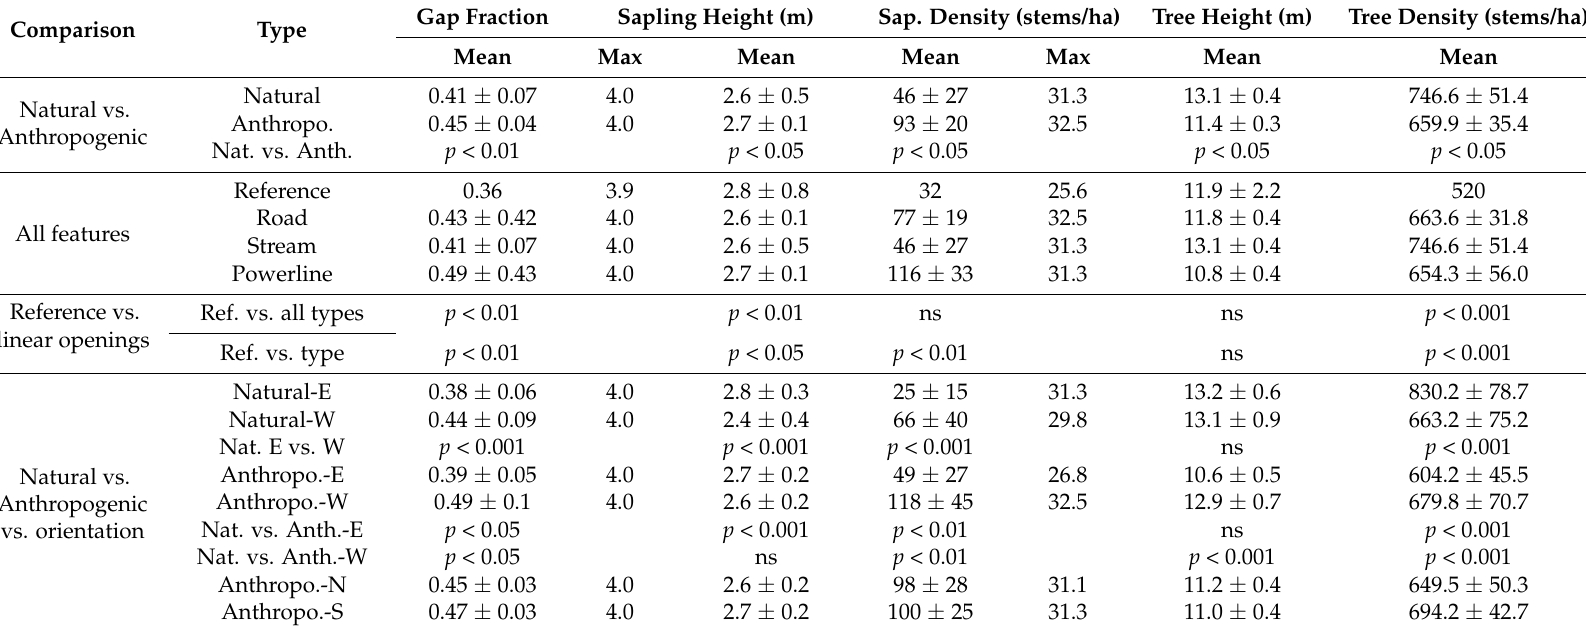
Table 2. Comparison of general characteristics of the forest conditions surrounding the selected linear openings (up to 100 m from the edge). Comparison